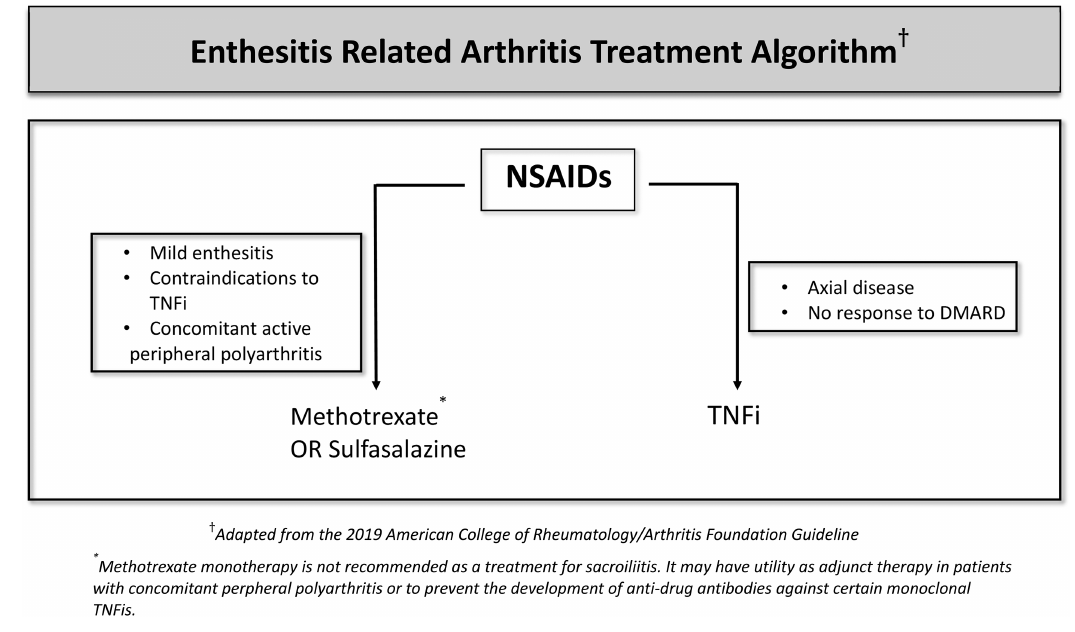
TABLE 1 ERA treatment